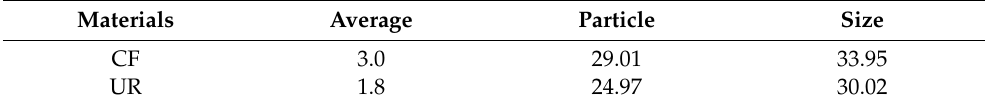
Table 2. Physical characteristics of the measured granular materials.